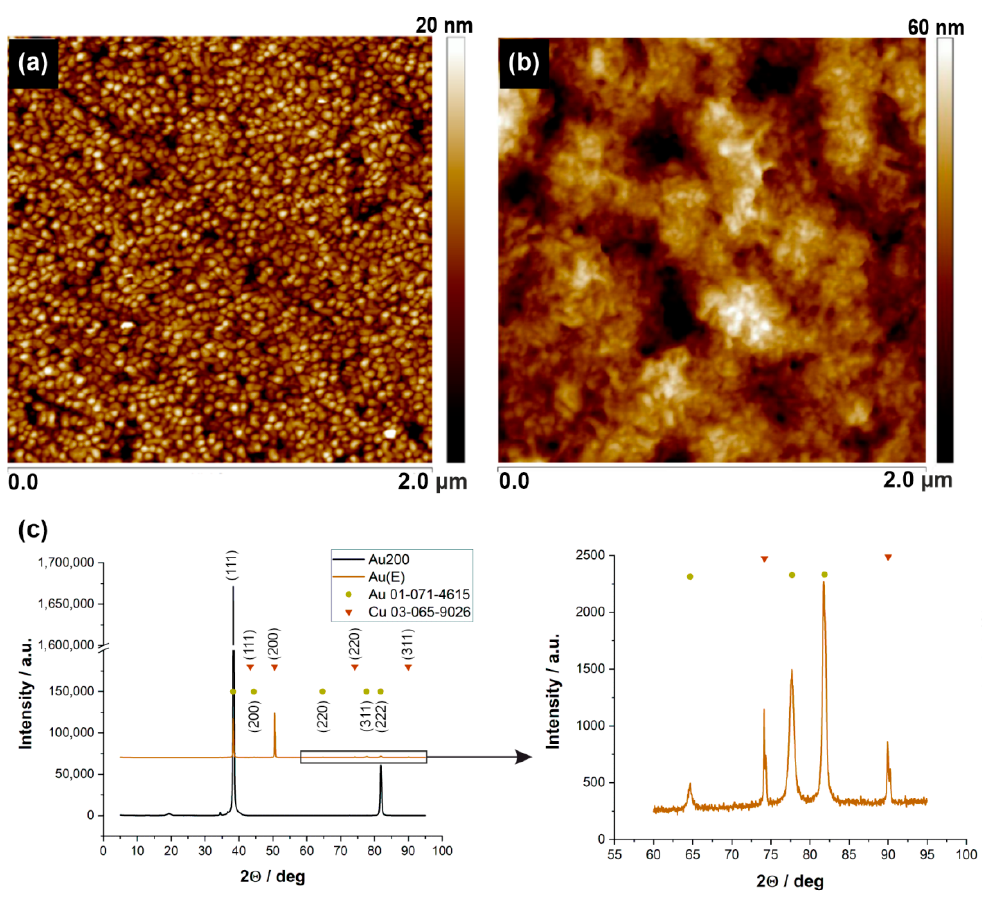
Figure 2. 2D AFM topography images of ( a ) commercially available gold layer (200 nm) on the glass; ( b ) Au(E) obtained electrochemically. ( c ) XRD patterns of Au200 and Au(E) substrates with characteristic reflections from gold and copper.